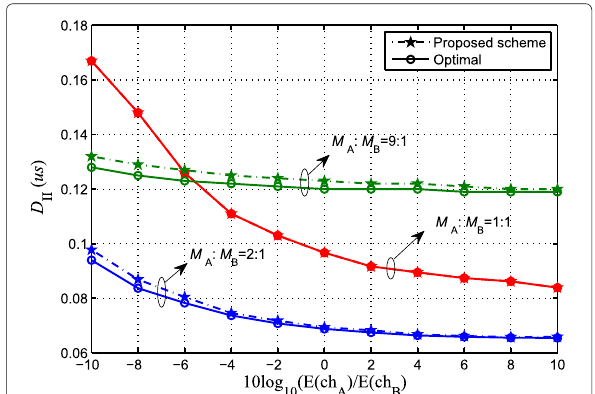
Fig. 5 D II performance comparison of optimal and proposed suboptimal